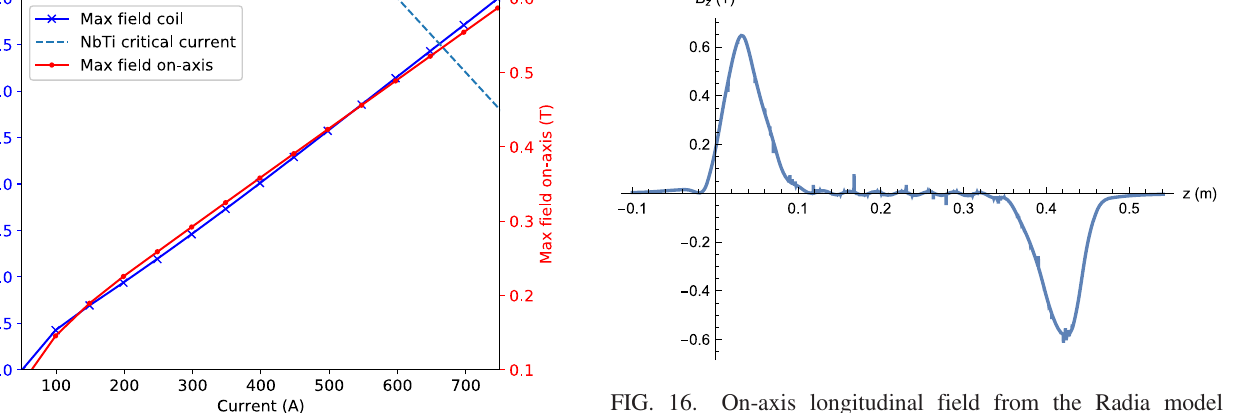
FIG. 16. On-axis longitudinal field from the Radia model simulation.